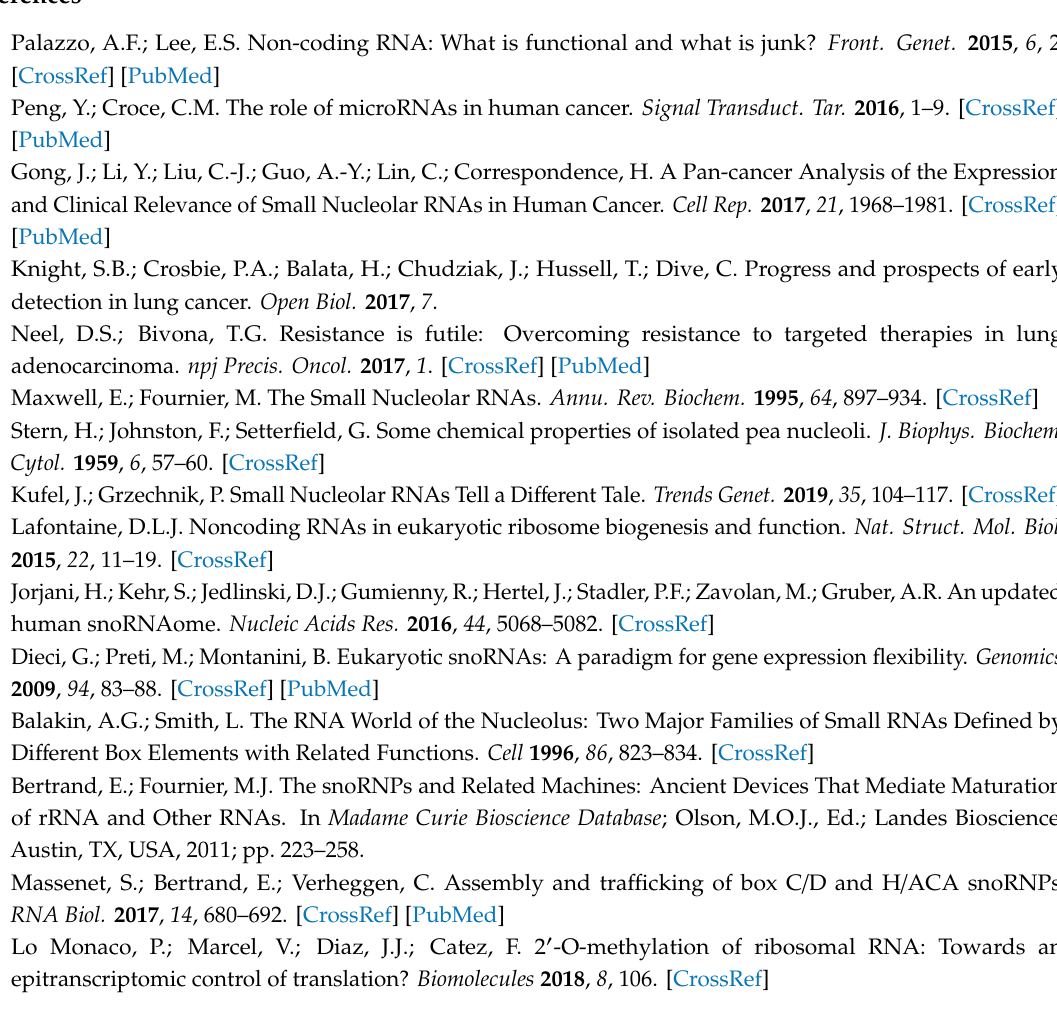
Table S1: snoRNA